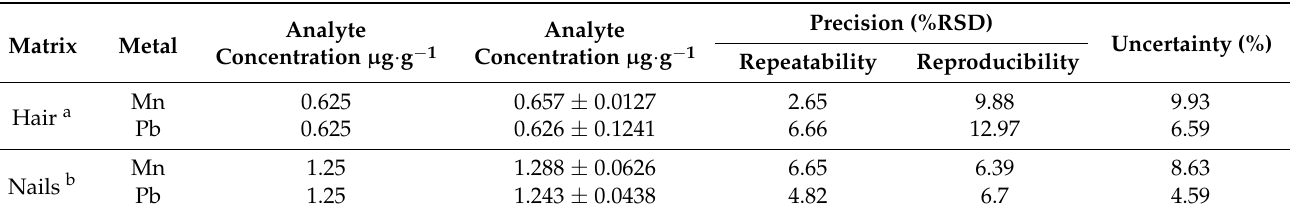
Table 5. Precision and Uncertainty data.